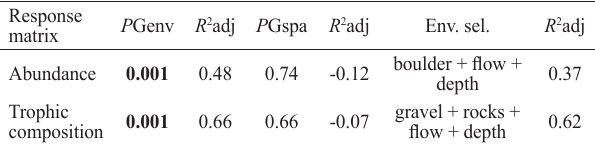
Table 3. Results of the redundancy analysis for the species abundance and trophic composition. P-values lower than 0.05 are indicated in bold; PGenv - P-values of global environmental models; PGspa - P-values of global spatial models including eigenvectors associated with positive eigenvalues; env. sel. - environmental variables selected.